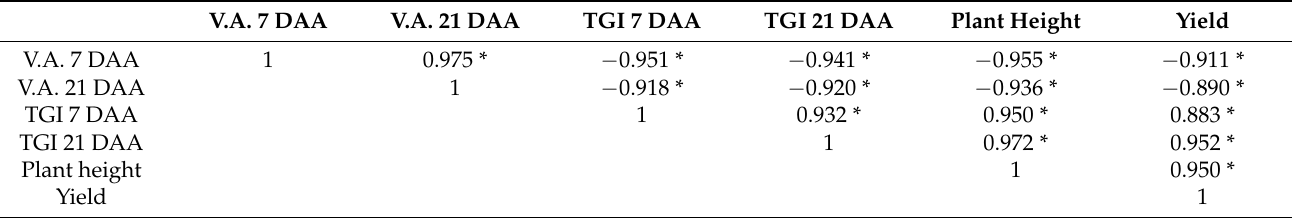
Table 3. Pearson correlation ( r ) among evaluated